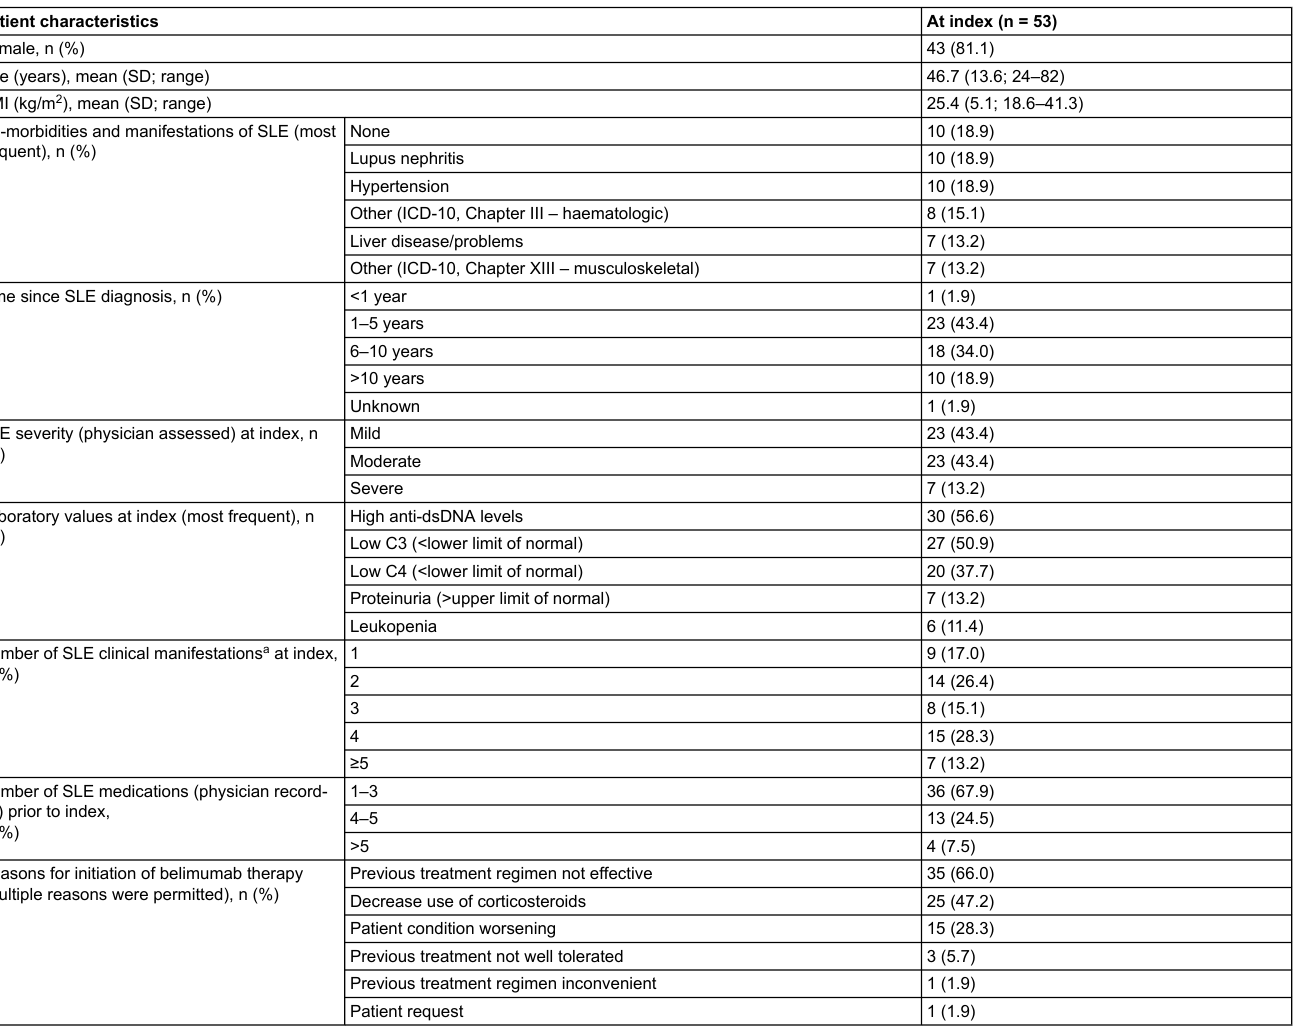
Table 1: Patient characteristics (n =